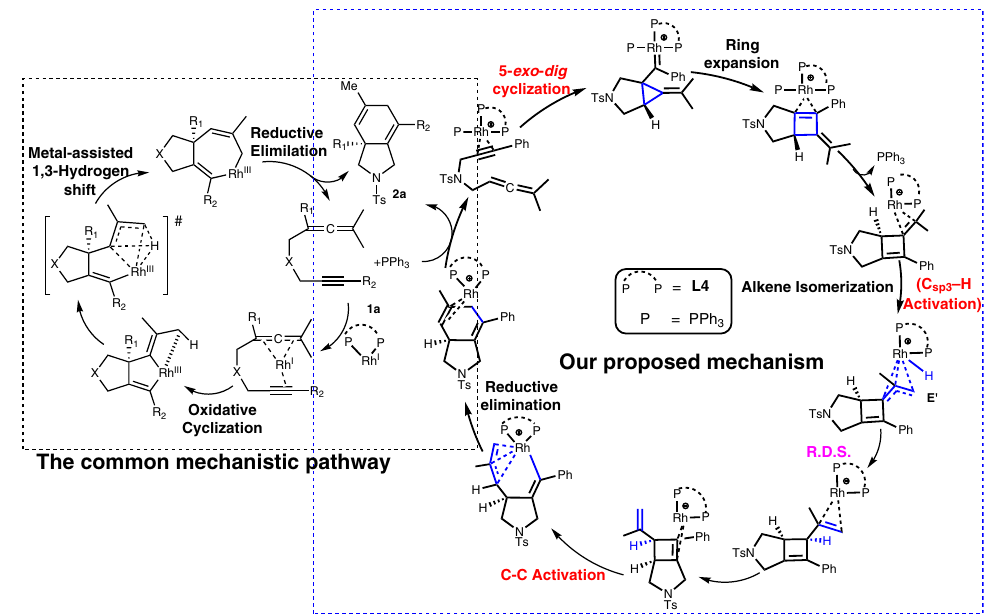
Fig. 4 The mechanistic pathways. The common pathway and our proposed pathway for the uncommon formation of 5/6-Fused Bicycle[4.3.0]nonadienes